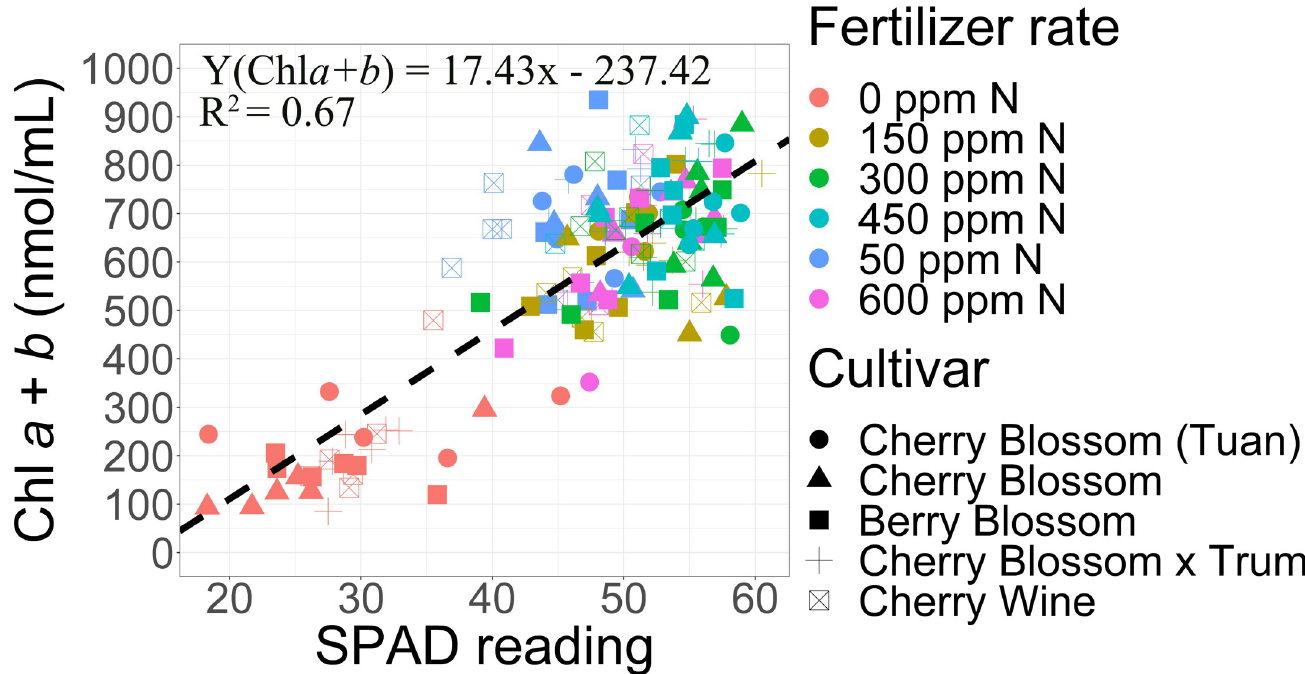
Fig 2. Linear relationships between SPAD 502 meter and total chlorophyll (a+b) concentrations at vegetative to floral transition.